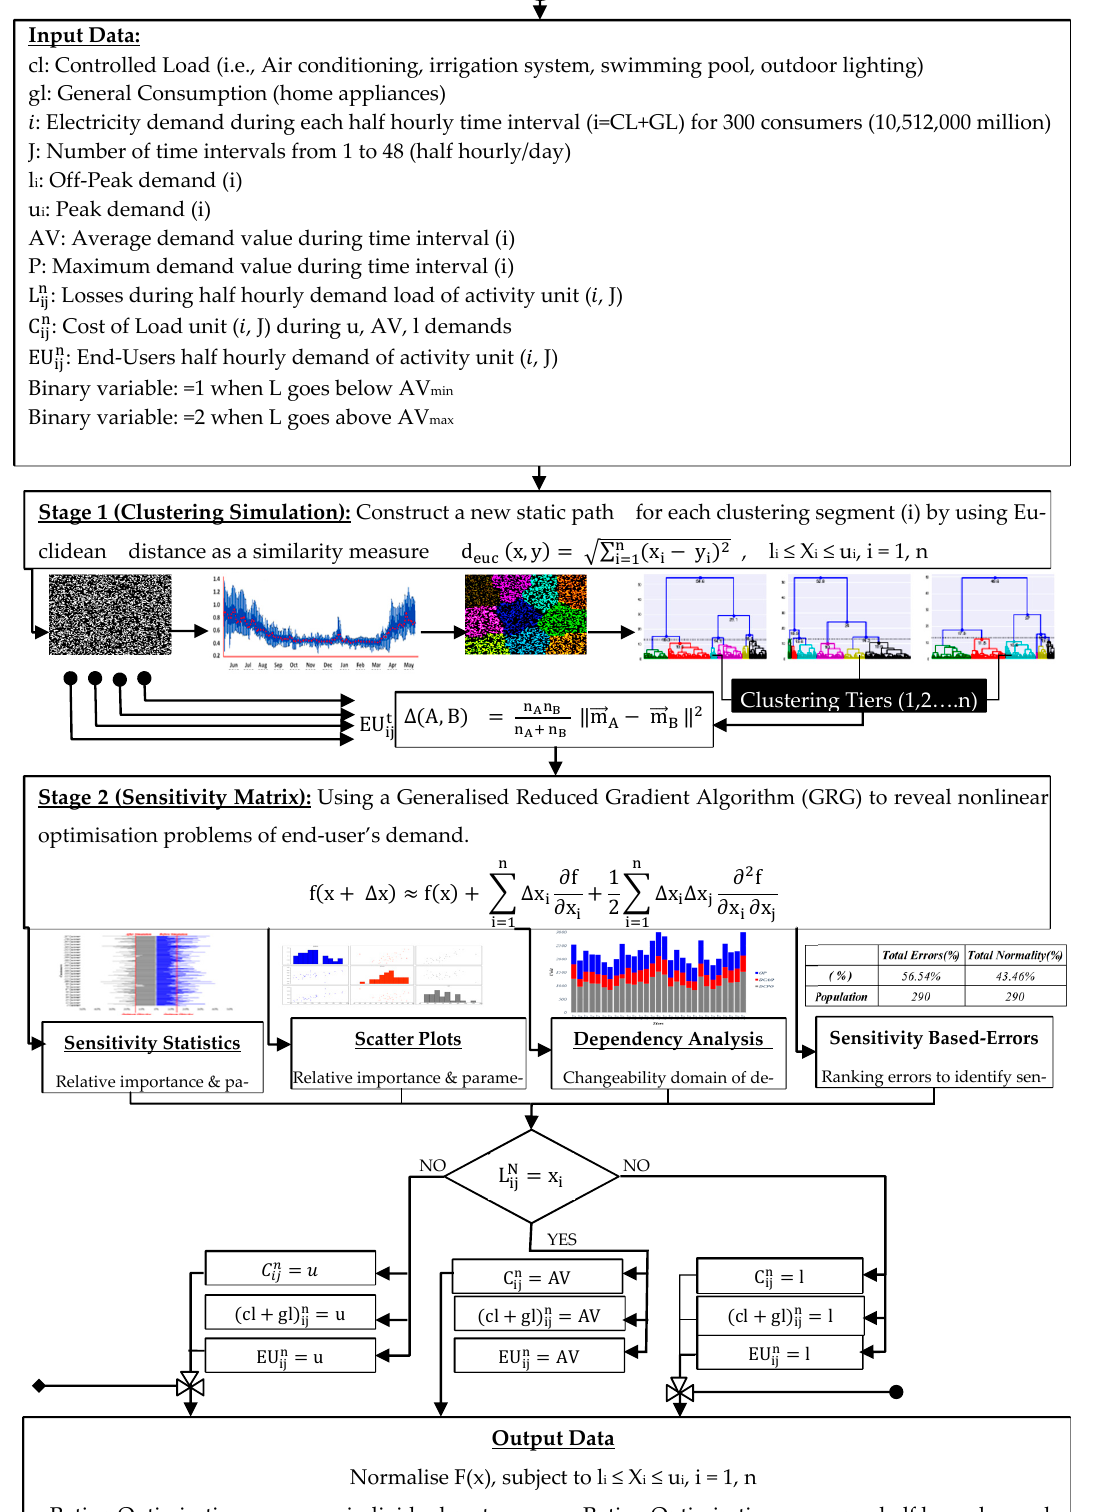
Figure 3. Simulation Optimisation